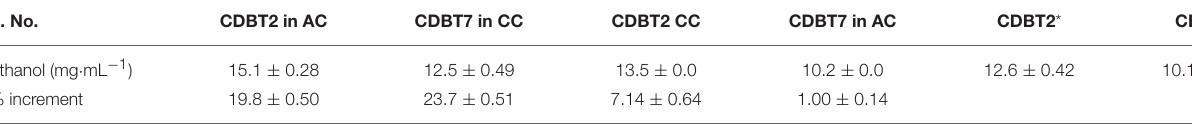
TABLE 1 | Ethanol produced by CDBT2 and CDBT7 cultured in different compartments. S. No.